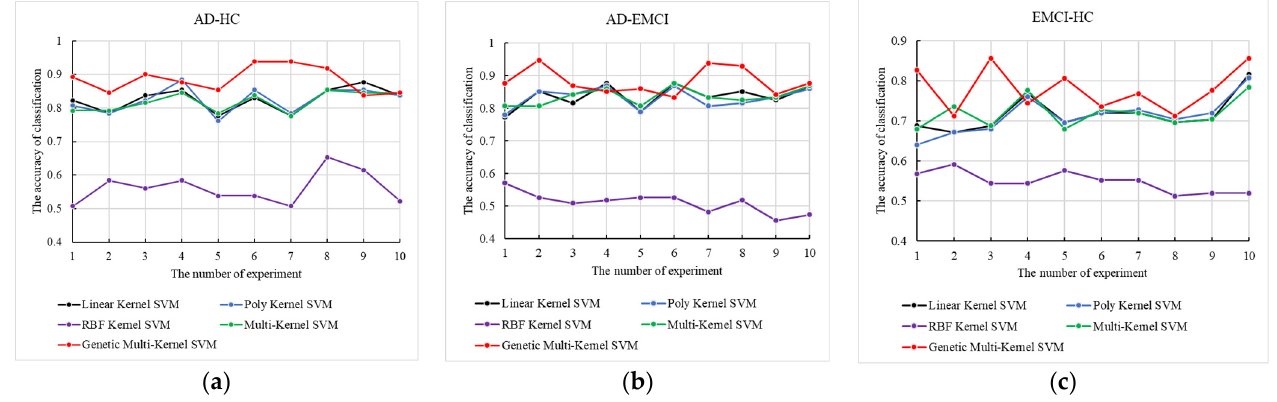
Figure 4. The 10 independent repeat experiments of the 5 methods on ( a ) AD-HC, ( b ) AD-EMCI and ( c ) EMCI-HC.